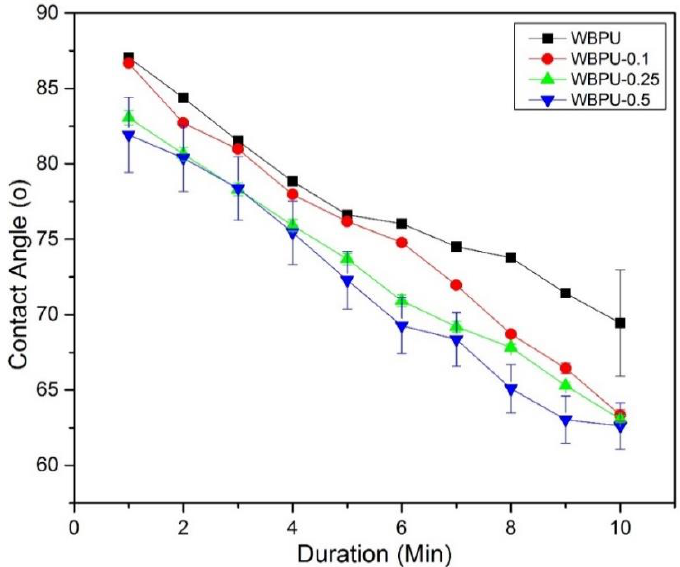
Figure 7. Contact Angle for WBPU and WBPU-CNF nanocomposite films. The water droplets of the neat WBPU have hardly changed on the surface of the neat film during the test process, indicating a small absorption of the film water. In the case of the WBPU-CNF composite, the contact angle decreased gradually as the CNF content increased from 0.1 to 0.5 wt.%. The reason could be attributed to the hydrophilic nature of the CNF [45], while the higher surface roughness and lower surface free energy have affected the hydrophobic surface of the film [46]. It could be seen in the FESEM images that WBPU-0.5 showed a bit of surface roughness that supported this finding because the WBPU-0.5 nanocomposite film indicated the lowest angle of contact with water. In the present study, the contact angle of the neat WBPU and WBPU-CNF nanocomposite films was between 79 ◦ and 87 ◦ , which was almost hydrophobic (90 ◦ ). This was attributed to the molecular level movement restriction further explained in Section